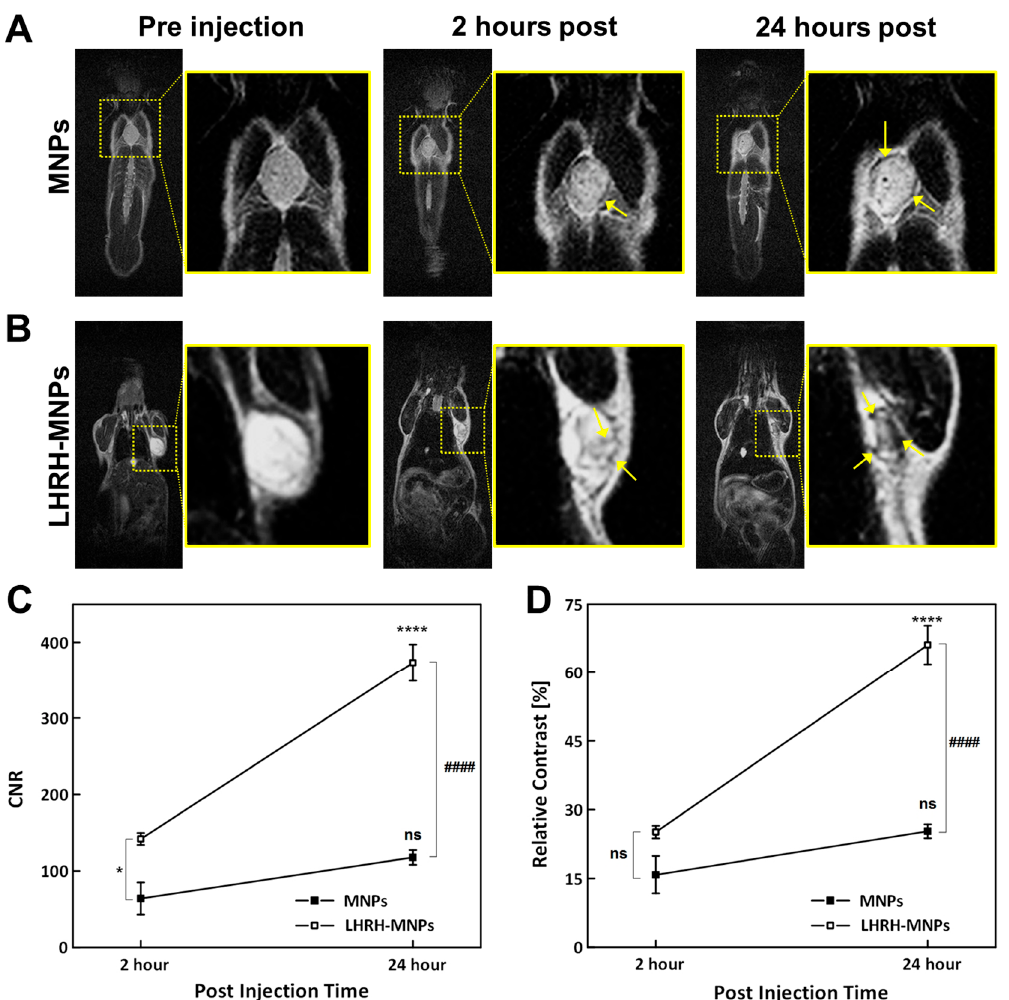
Figure 9. T2-weighted MR images of nude mice bearing breast tumor 4-week post tumor implantation before and after intravenous injection using ( A ) MNPs or ( B ) LHRH-MNPs. Tumor sites in mice are identified by yellow dotted rectangles, and the darkened areas within the tumors are highlighted with yellow arrows in zoomed-in images focusing on tumor sites. The same animal was scanned before, 2 h post and 24 h following nanoparticle injection. ( C ) CNR of MNPs and LHRH-MNPs treated tumors. ( D ) Relative contrast of MNPs and LHRH-MNPs treated tumors. ns: not significant; * p < 0.05; **** and ####, p < 0.0001.